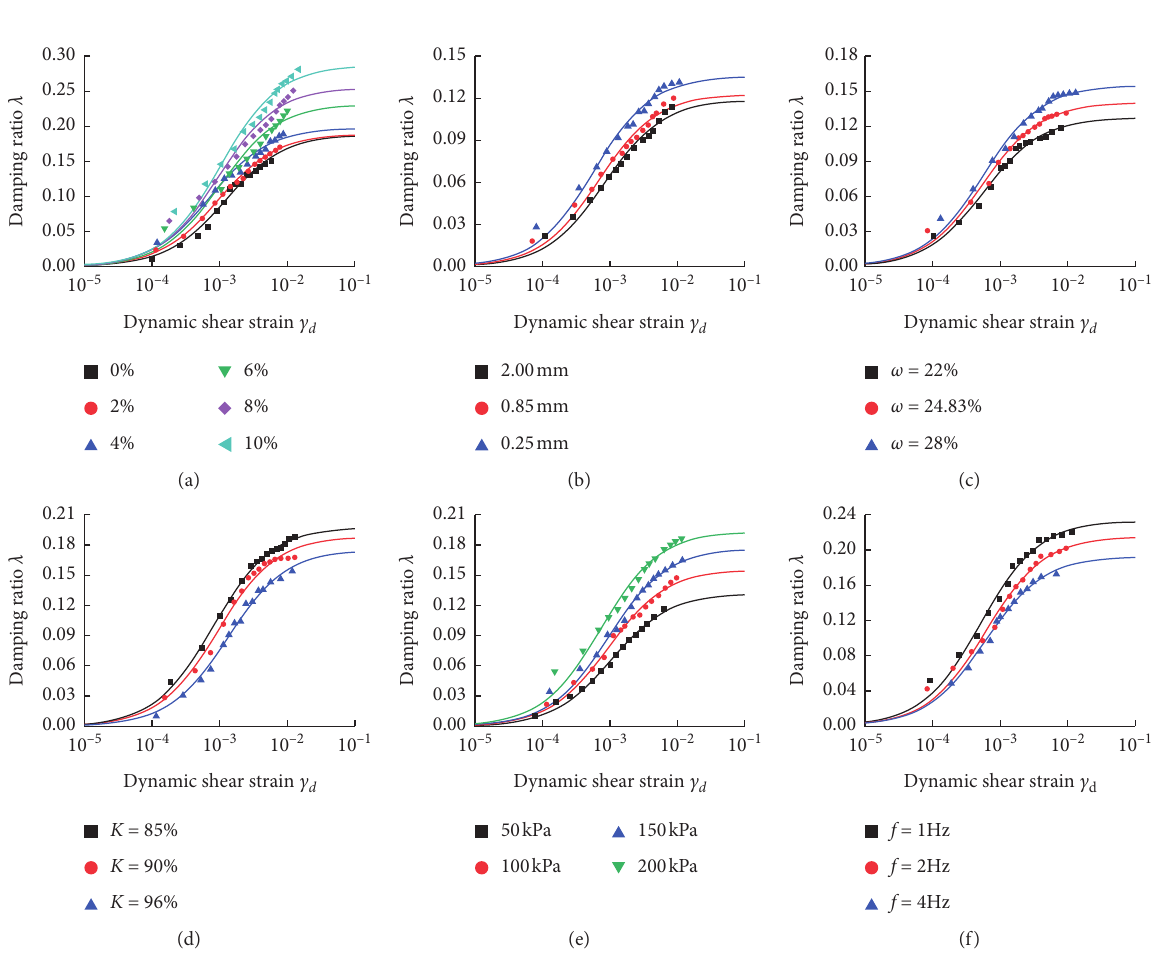
Figure 9: Rubber-red clay damping ratio and dynamic shear strain curve. (a) Rubber powder content; (b) rubber particle size; (c) moisture content; (d) compactness; (e) confining pressure; (f)